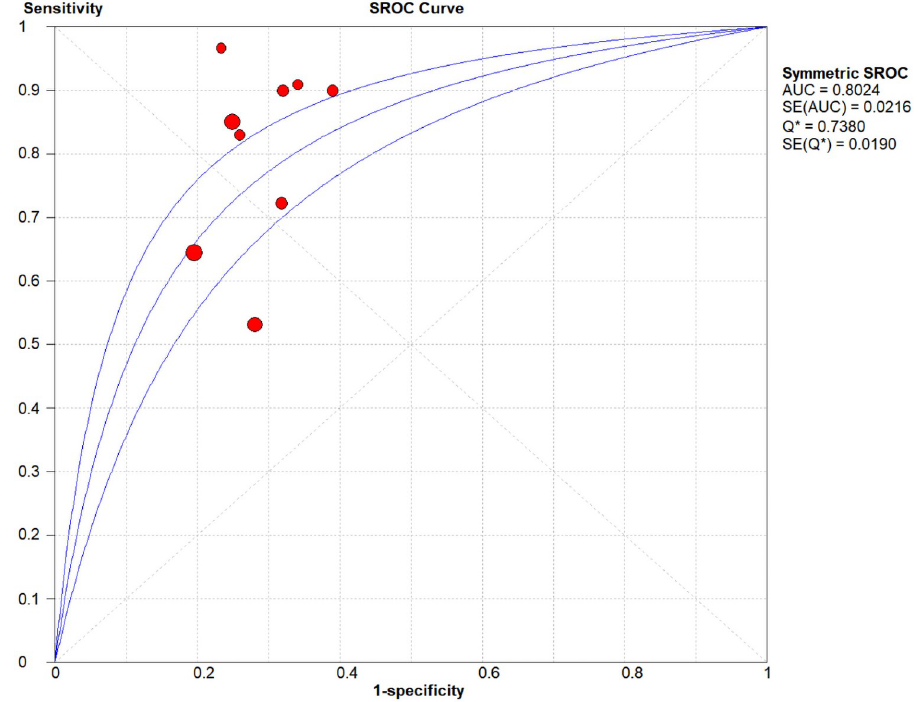
Fig 9. SROC with a 95% confidence